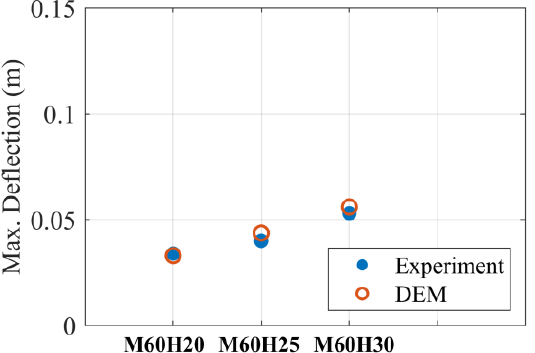
Figure 13. Comparison of maximum deflections obtained from the experiment and numerical anal- ysis.